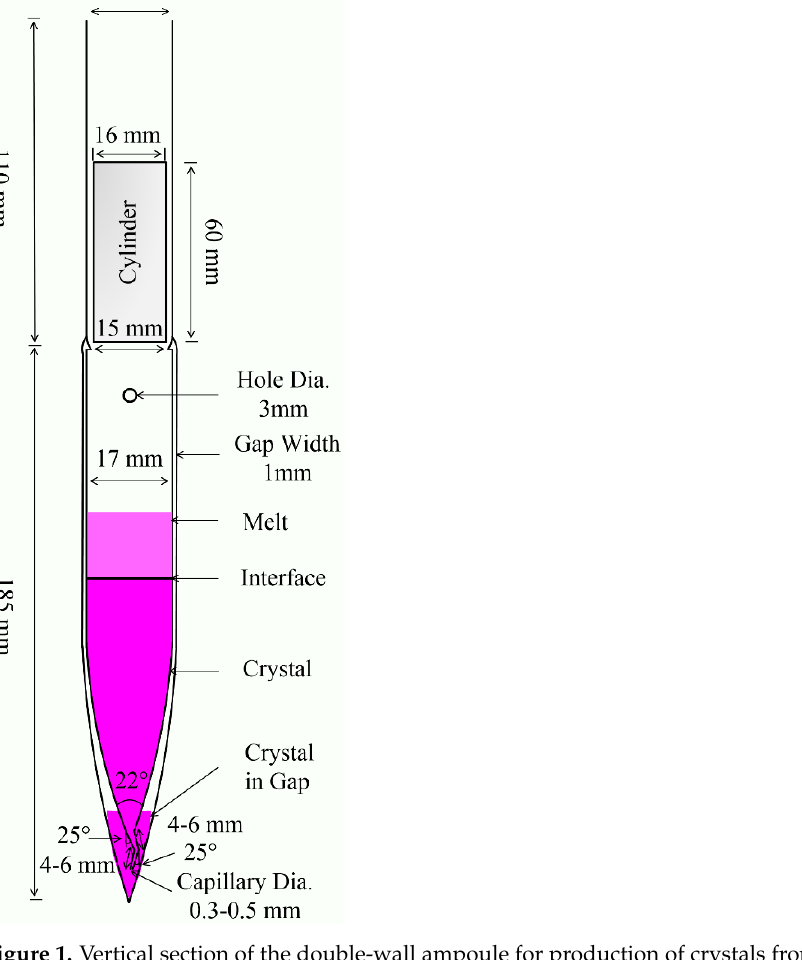
Figure 1. Vertical section of the double-wall ampoule for production of crystals from melt. The cone diameter of the inner tube was gradually shrunk to 2 mm before entering the capillary tube. The capillary was bent twice with a turning angle of 25 ◦ , and the